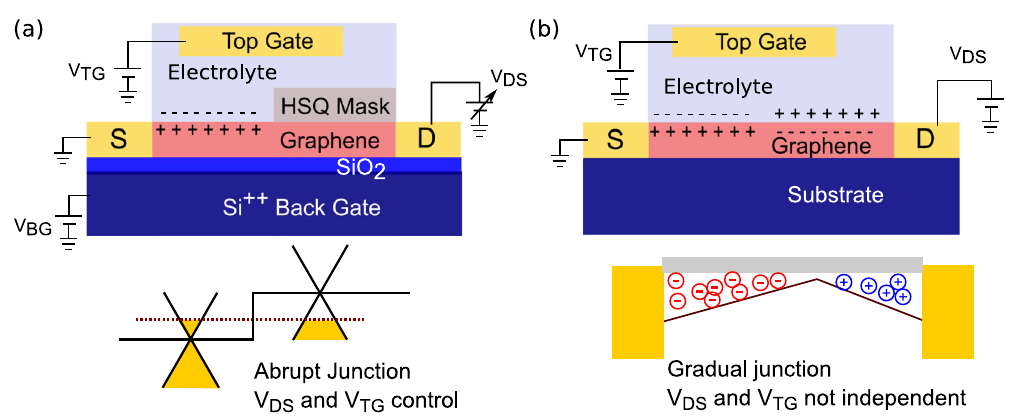
Figure 1. Comparison of the gating scheme discussed in this work with that used previously. (a) Schematic of our gating scheme and the corresponding band diagram with abrupt p-n junction and independent control of V DS . (b) Electrolytic gating scheme used in previous experiments 27, 28 where a combination of V DS and V GS is used to create a junction which is not abrupt and does not allow independent control of V DS and the barrier